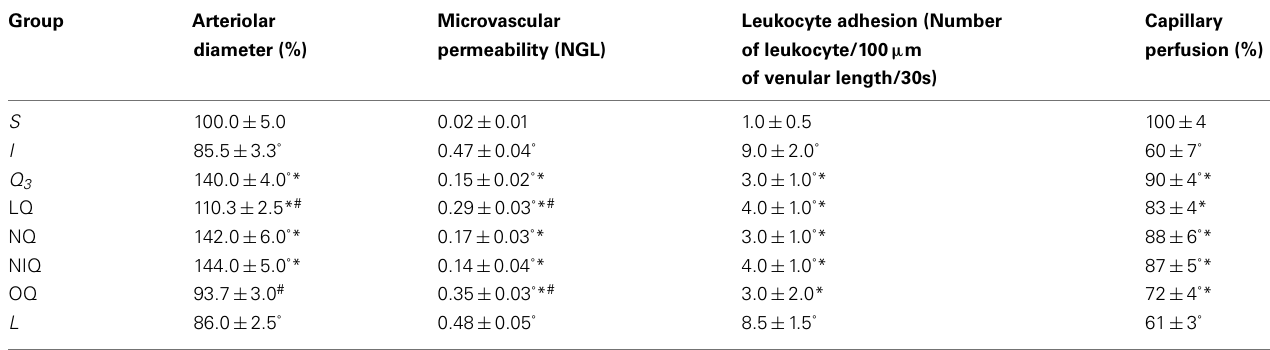
Table 4 | Mean arterial blood pressure (MABP) under baseline conditions, at the end of bilateral common carotid artery occlusion (BCCAO) and at the end of reperfusion (RE) in sham-operated ( S ) group, ischemic ( I ) group, and quercetin ( Q 3 ) subgroup (5mg/kg